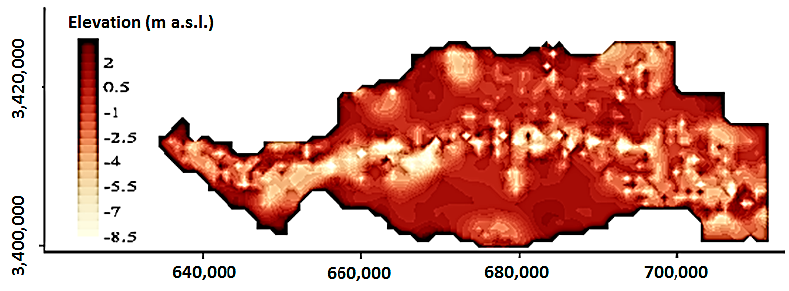
Figure 2. Topography of the Al-Hammar Marsh.